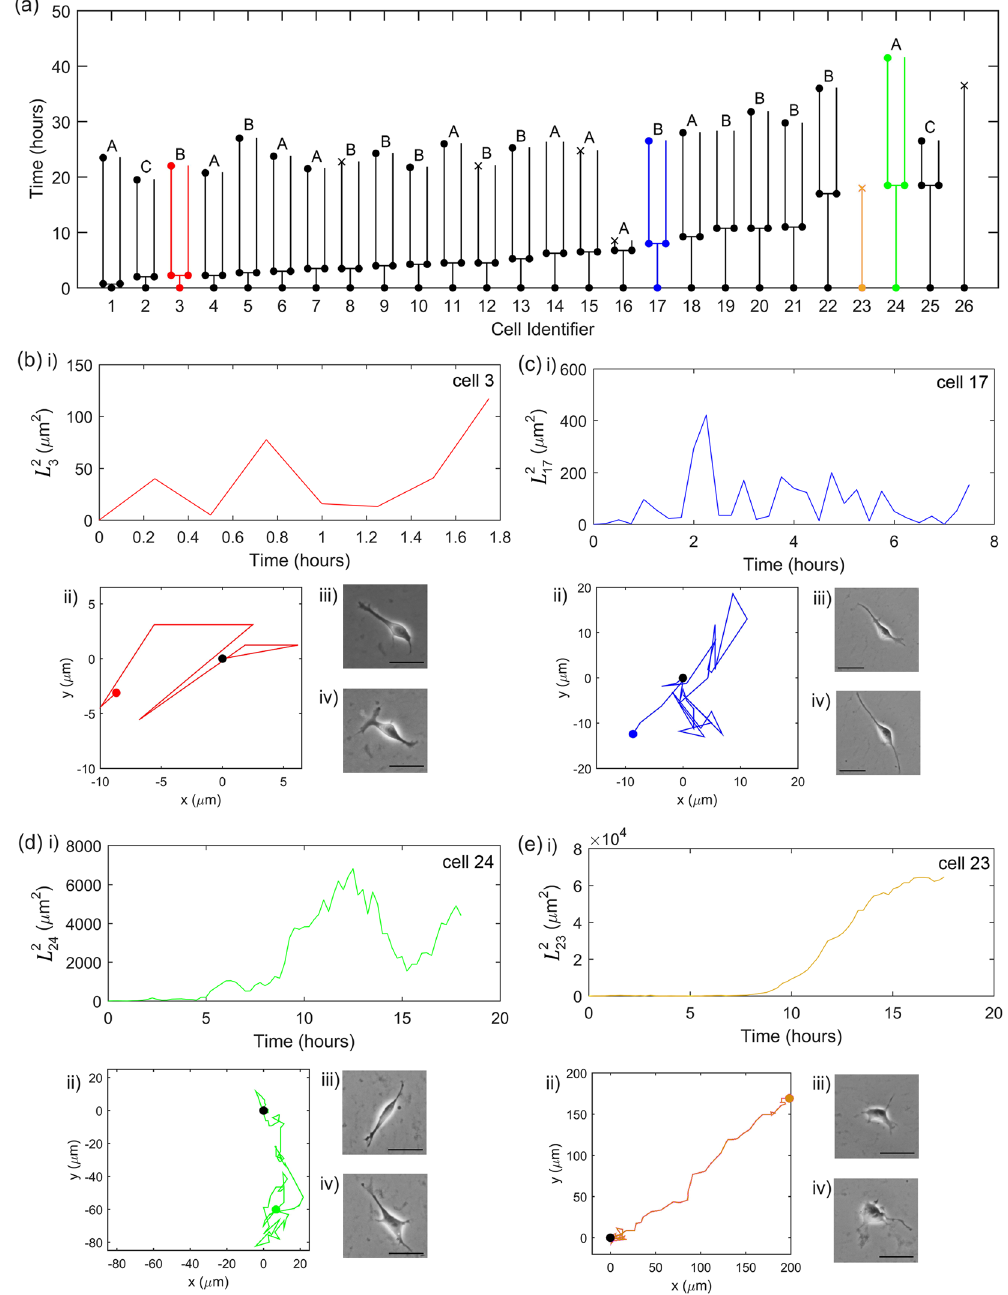
Figure 1. Single-cell behaviour in the absence of Cell Tracer. ( a ) The timelines of the 26 single cells. A filled circle indicates that the cell has divided, a cross indicates the cell has died, and no marker indicates that the image was not clear enough to identify the cell confidently; in both cases, we did not track cells beyond this point. The range of behaviours is illustrated with Cell 3 (red), 17 (blue), 23 (orange) and 24 (green), as detailed in Panels (b–e). The predominant behaviour is that similar to Cell 17. In each case, we show (i) L of time, (ii) the cell trajectory (with the black and coloured circles indicating the start and end of the trajectory, respectively), and its microscopy images at (iii) the start of the recording and (iv) close to the end of its walk. The length of the scale bar shown within the microscopic images is 50 μ m. The sampling interval is 15 minutes and the microscope resolution is 0.62 μ